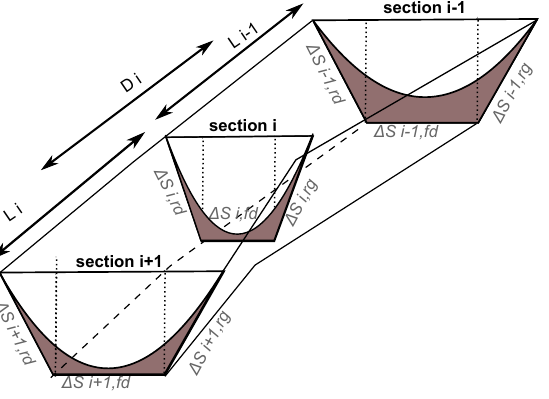
Fig. 3. Representation of the calculation variables 1S i, bk = 1S i, left + 1S i, right